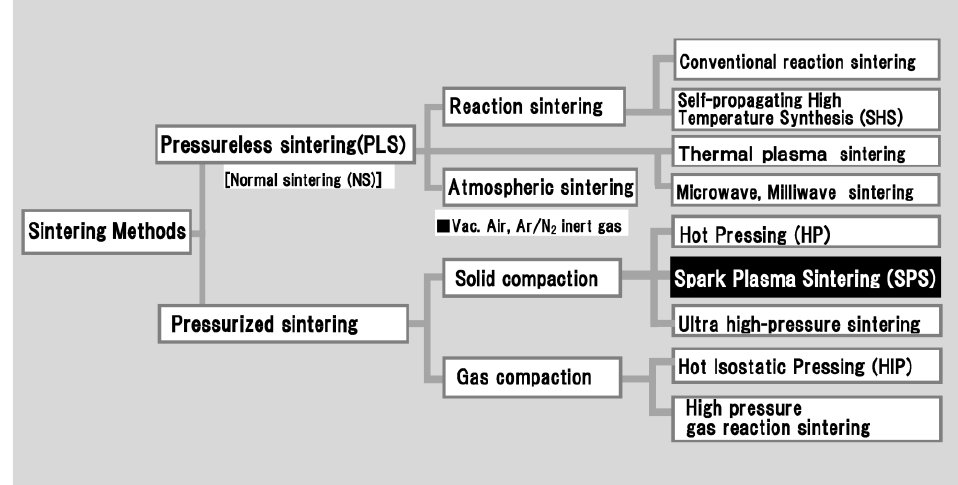
Figure 5. Typical classification of sintering methods.